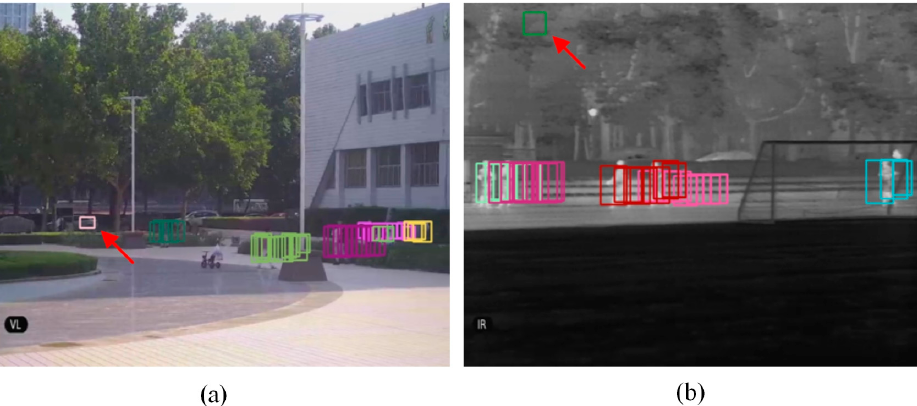
Figure 9. AWMPF applied to ( a ) VS frames and ( b ) IR frames. The rectangles with the same color represent the pipeline of a person. The red arrows are pointing to pseudo-targets. Table 3. Comparison of moving object detection results with and without applying